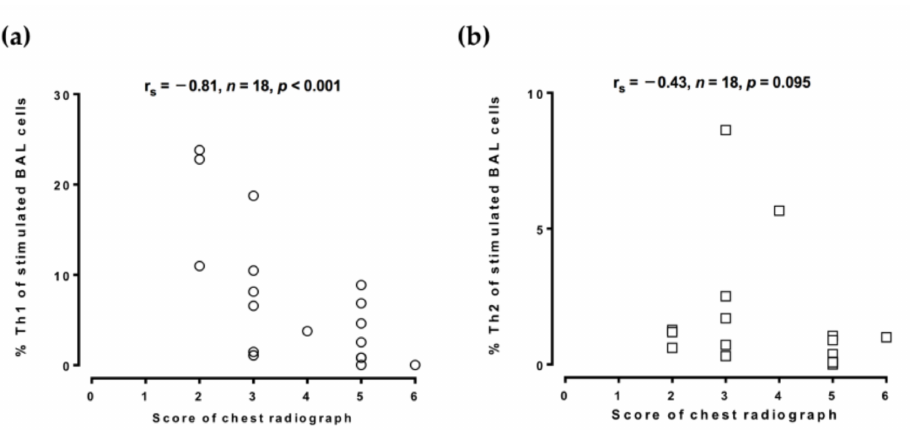
Figure 3. Inverse association between the proportion of BAL Th1 cells and chest radiographic severity score. Cells from the TB-infected patients and non-TB subjects were collected by bronchoalveolar lavage and stimulated with phorbol myristate acetate and ionomycin. CD4 + /IFN- γ + Th1 cells and CD4 + /IL-4 + Th2 cells were identified by flow cytometry. ( a , b ) The association between the chest radiographic severity score and the proportion of Th1 cells or Th2 cells was determined by Spearman’s rank correlation. BAL, bronchoalveolar lavage; %Th1, percentage of type 1 CD4 + T helper cells; %Th2, percentage of type 2 CD4 + T helper cells; TB, tuberculosis; IL-4, interleukin-4; IFN- γ , interferon- γ